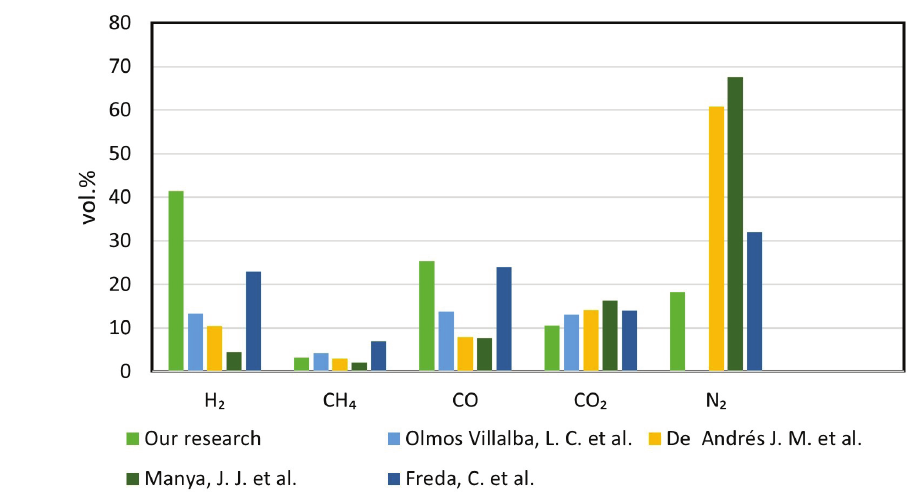
Fig. 2 – Comparison of syngas composition from Zagreb SS gasification and experimental data from the literature